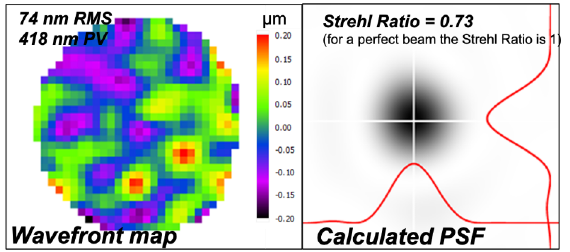
Figure 2. Wavefront map and calculated PSF at the output of the LBTS, in the experimental area, showing a good focusability of the laser pulses, with a calculated Strehl Ratio of 0.73.